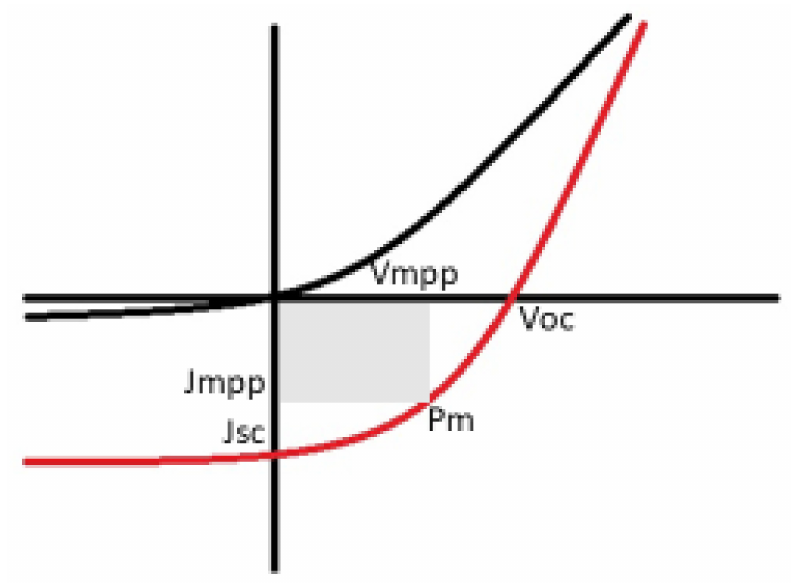
Figure 4. Represents a schematic current–voltage curve from a solar cell device black (dark) and red (under illumination)